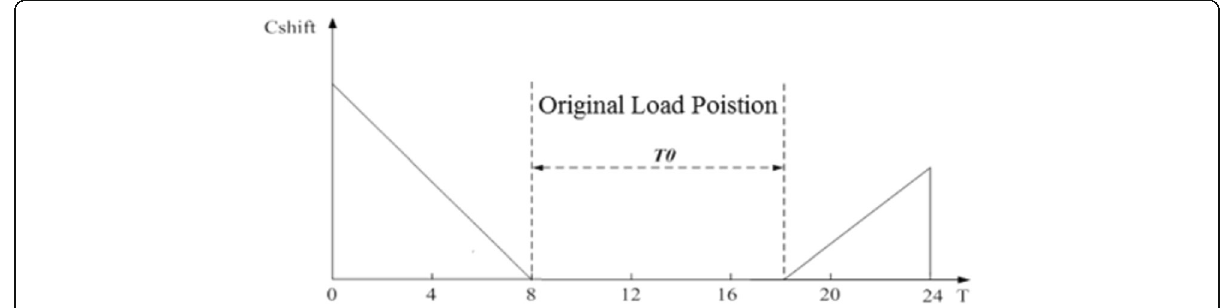
Fig. 6 Load Shifting Cost Curve (should be Fig. 6, it ’ s changed to Fig. 2 after building the PDF and I cannot figure out